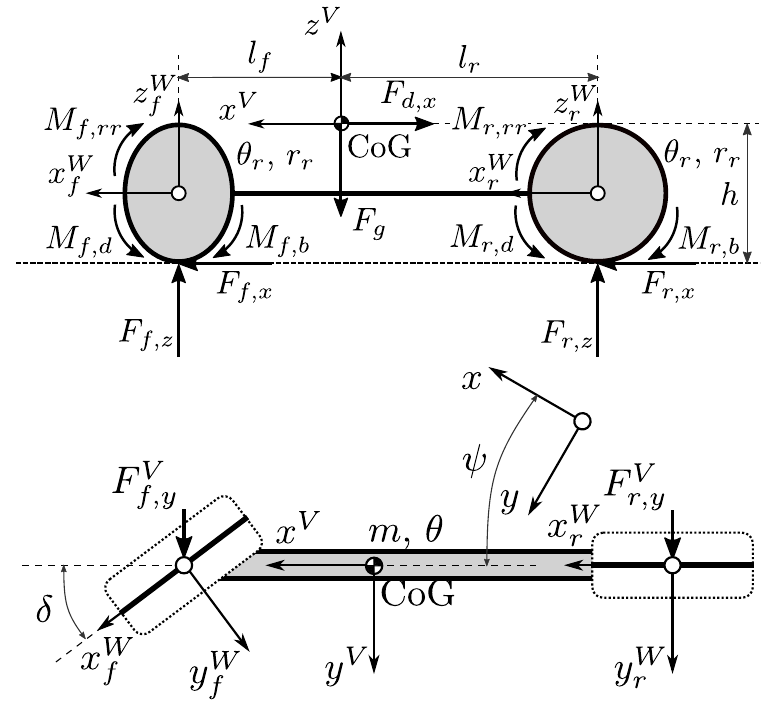
Figure 3. Sideview and top view of the single track nonlinear model [29]. Table 2. Parameters of the vehicle